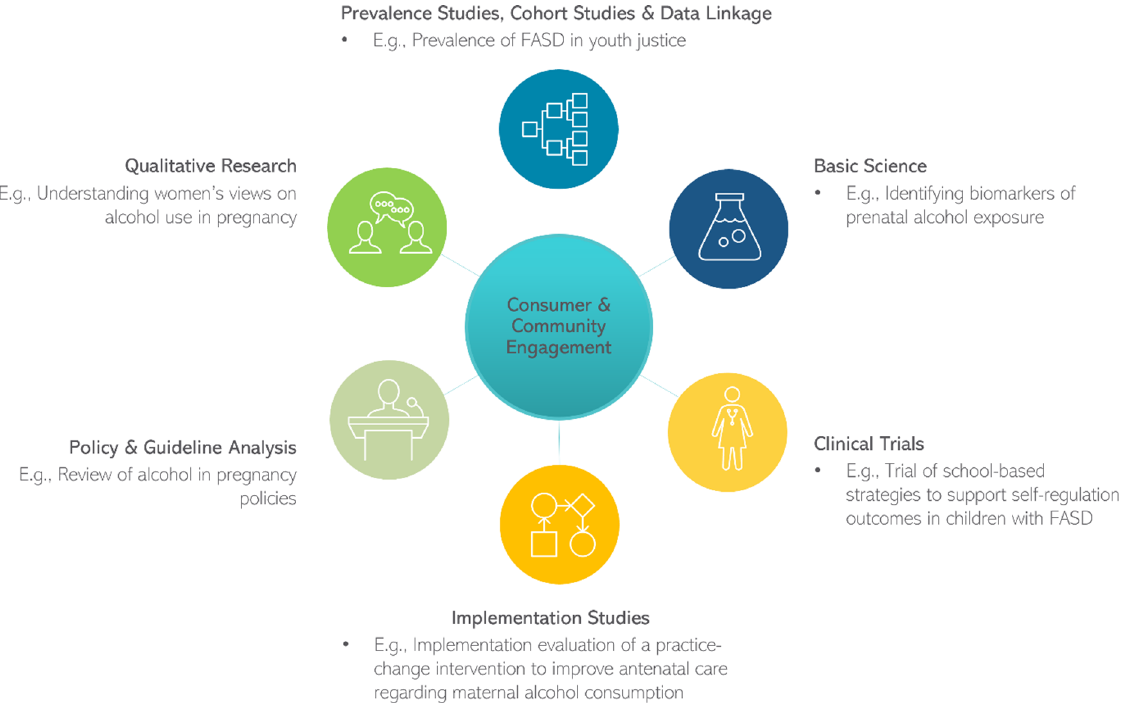
Figure 2: Overview of different types of research conducted within the